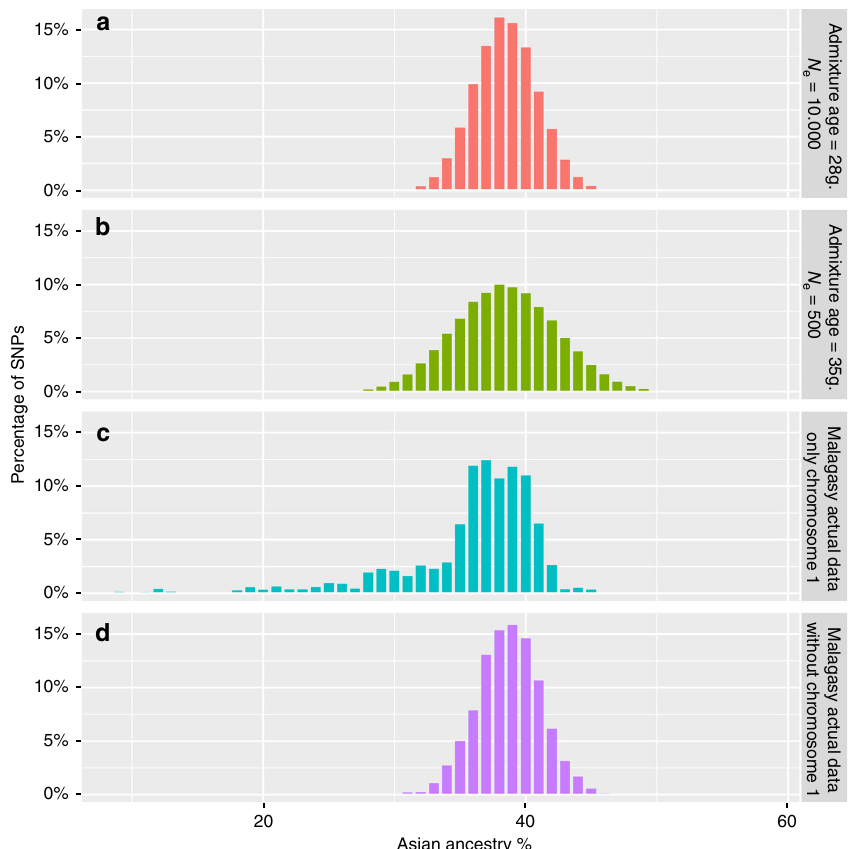
Fig. 3 Distribution of Asian ancestry across the genome. a The simulated distribution based on the “ realistic model ” . b The simulated distribution based on the “ drift model ” . c The observed distribution for all positions on chromosome 1. d The observed distribution for all positions in the genome (excluding chromosome